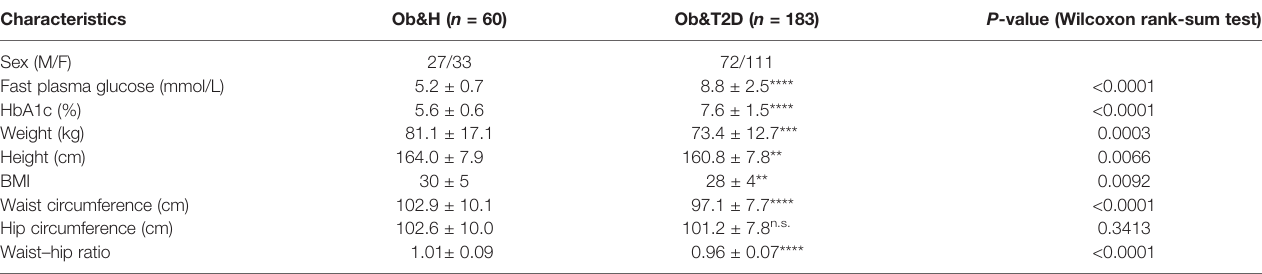
TABLE 1 | The overall characteristics of the participants in this study. Characteristics